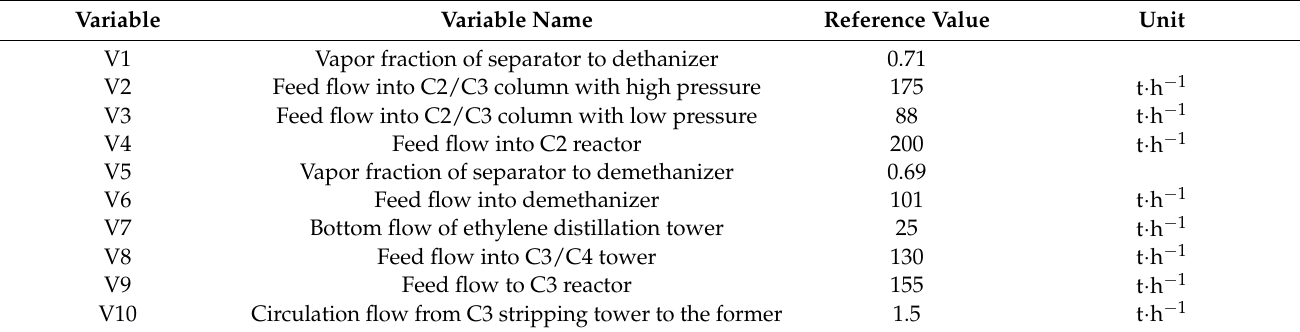
Table 8. Correlation degree of 10 variables. d